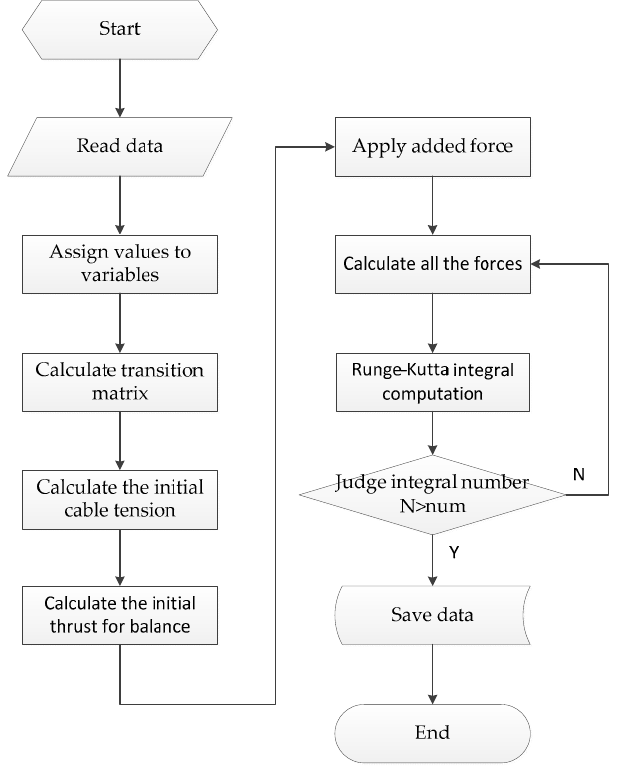
Figure 5. Flow chart of tethered ROV motion simulation.